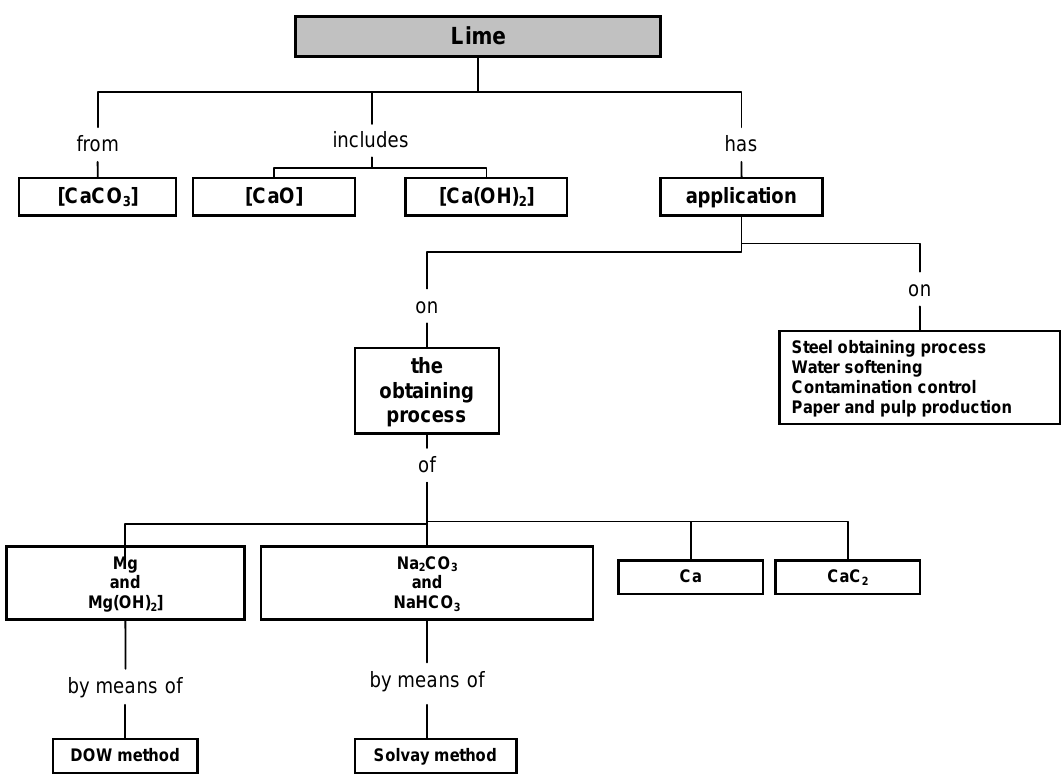
Figure 2. “Example of concept map elaborated by the lecturer in the subject Chemical Processes